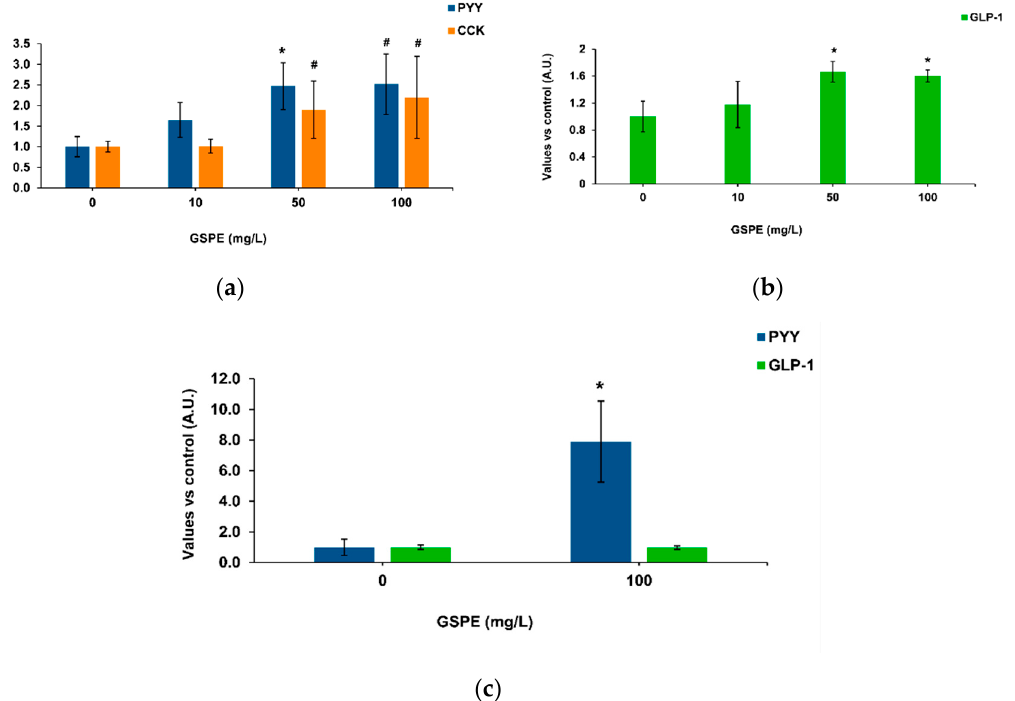
Figure 1. Enterohomone secretion levels in the basolateral medium after apical stimulation of pig intestinal segments with grape seed proanthocyanidin extract (GSPE). ( a ) Cholecystokinin (CCK) (orange columns) and peptide YY (PYY) (blue columns) secretion in duodenum. ( b ) Glucagon-like peptide 1 (GLP-1) secretion in ascending colon. ( c ) PYY (blue columns) and GLP-1 (green columns) secretion in descending colon. Results are expressed in arbitrary units (A.U.), which are values normalized versus the control and represent mean ± SEM. * p < 0.05 vs. control, # p < 0.1 t -test, n = 7– 15.